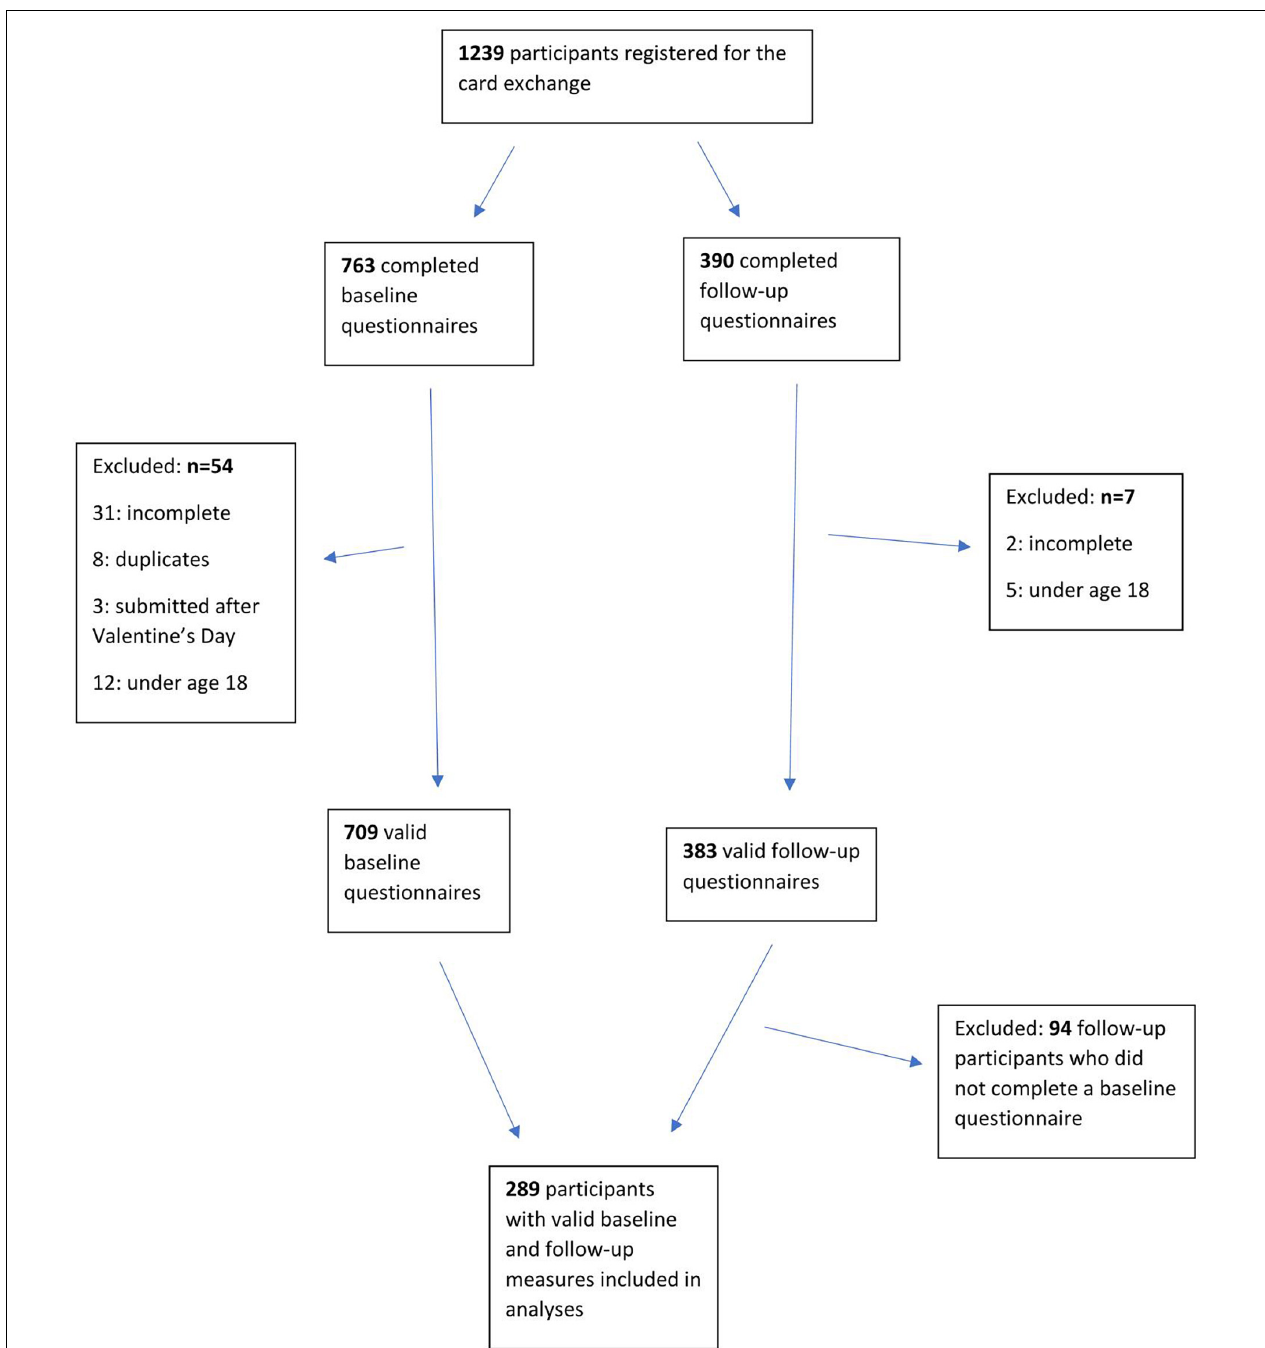
FIGURE 1 | Participants included in the Kindness by Post